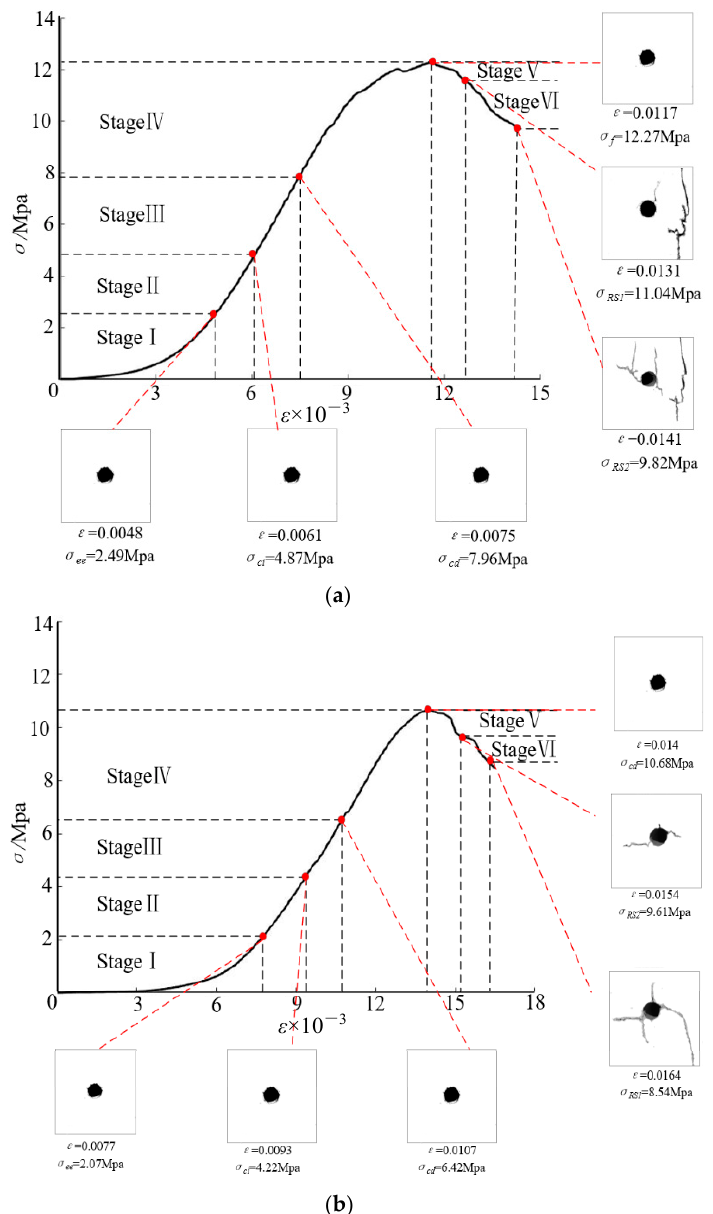
Figure 3. Stress ‒ strain curves of the moisture-bearing specimens. ( a ) HS-20%. ( b ) HS-40%. Figure 3. Stress–strain curves of the moisture-bearing specimens. ( a ) HS-20%. ( b ) The characteristic stress threshold values can be obtained from Figures 2 and 3, as shown in Table 1. Table 1. Typical specimen characteristic stress threshold values.